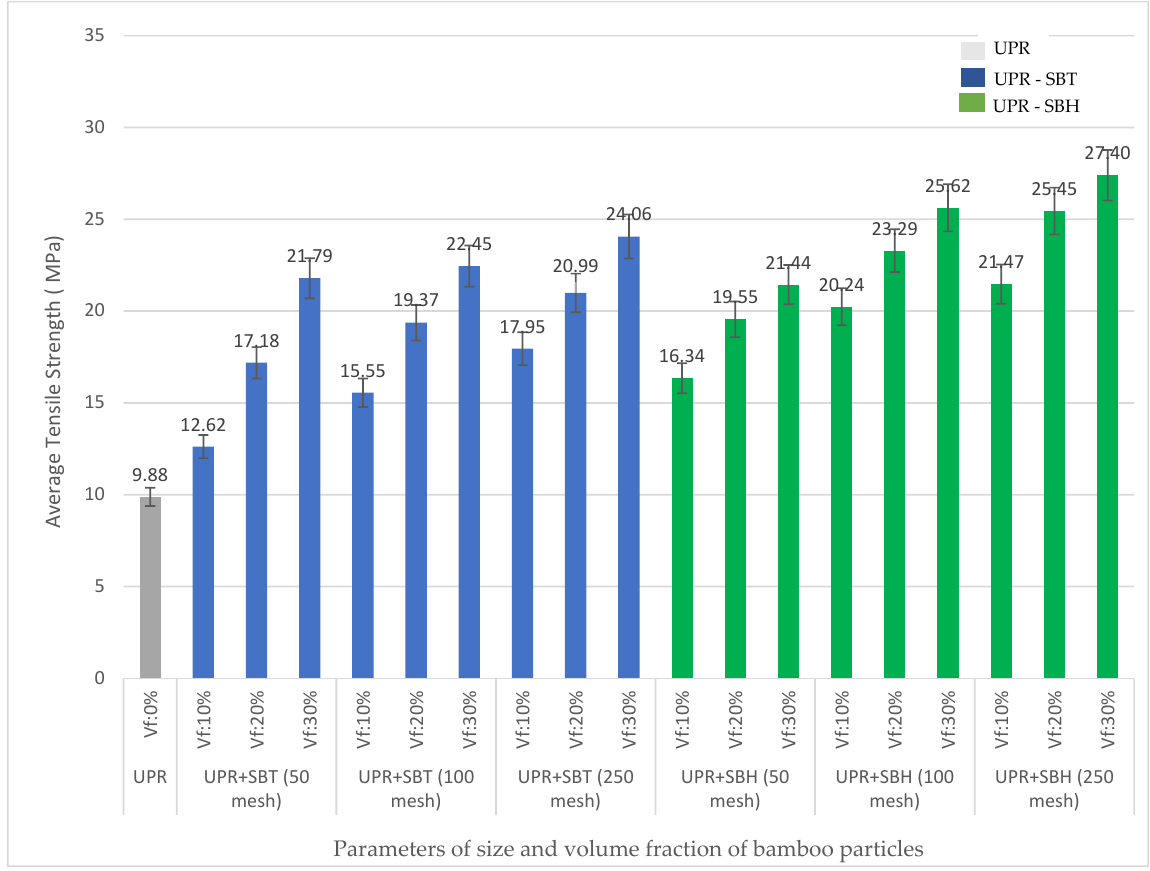
Figure 9. Relationship between volume fraction on the particle size of SBT and SBH polyester (UPR) matrix on tensile strength.